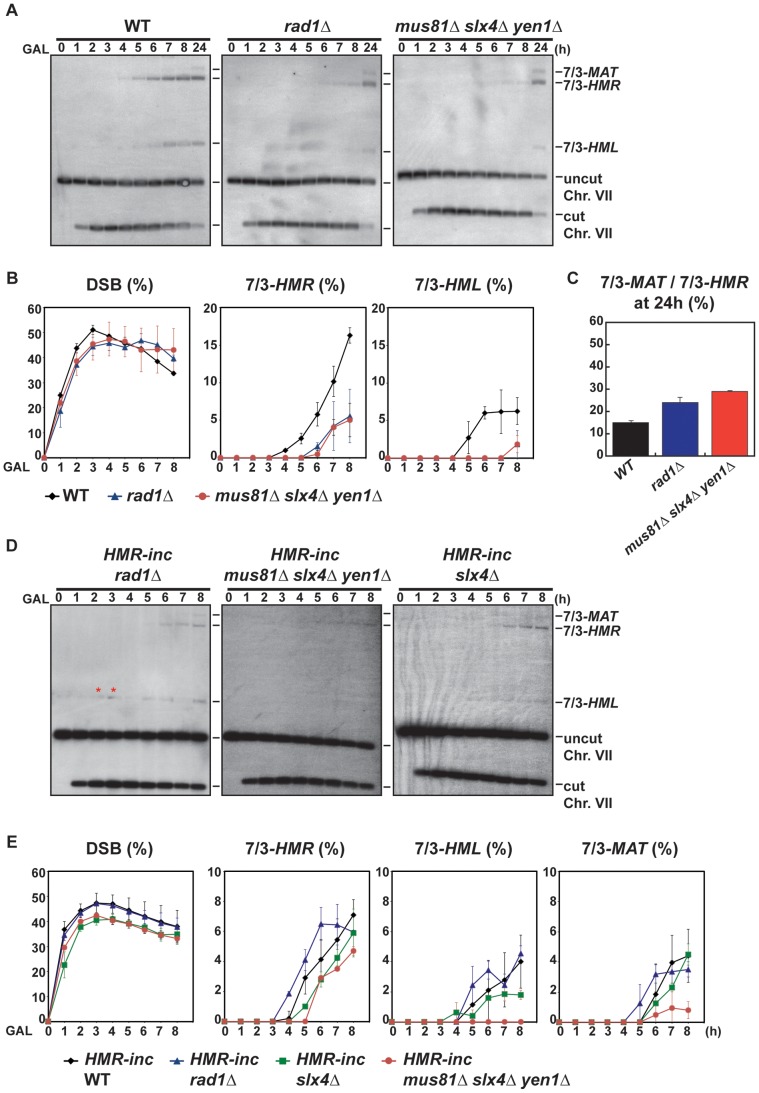
Template switching is affected in mus81Δ slx4Δ yen1Δ but not in rad1Δ mutants.(A) Appearance of BIR repair products, as monitored by Southern analysis, in WT, rad1Δ and mus81Δ slx4Δ yen1Δ strains. Experiments were performed as described in Figure 2C. (B) Quantification of BIR product accumulation. Quantification results for chromosome VII cleavage (DSB), 7/3-HMR and 7/3-HML BIR intermediate accumulation are shown in percent. (C) Quantification of 7/3-MAT/7/3-HMR BIR intermediate ratios 24 h after HO induction. Mean values and standard deviations for 2–3 independent experiments are shown. (D) Appearance of BIR repair products, as monitored by Southern analysis, in HMR-inc rad1Δ, HMR-inc mus81Δ slx4Δ yen1Δ and HMR-inc slx4Δ strains. (E) Quantification of BIR product accumulation. Quantification results for chromosome VII cleavage (DSB), 7/3-HMR, 7/3-HML and 7/3-MAT BIR intermediate accumulation are shown in percent. Mean values and standard deviations for 2–3 independent experiments are shown. A representative Southern analysis is shown for each genotype analyzed. Positions of the bands corresponding to 7/3-MAT, 7/3-HMR and 7/3-HML intermediates, and to the uncut and cut chromosome VII (Chr. VII) are indicated. Bands marked with a red asterisk likely result from partial digestion. GAL, galactose; h, hours.